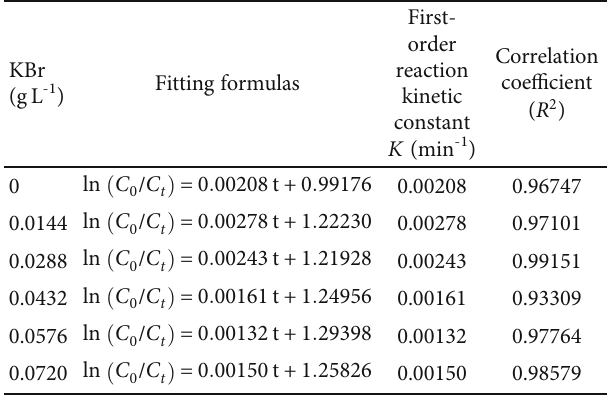
Table 2: Fitting results of fi rst-order reaction kinetics under alkaline condition ( pH = 9 : 37